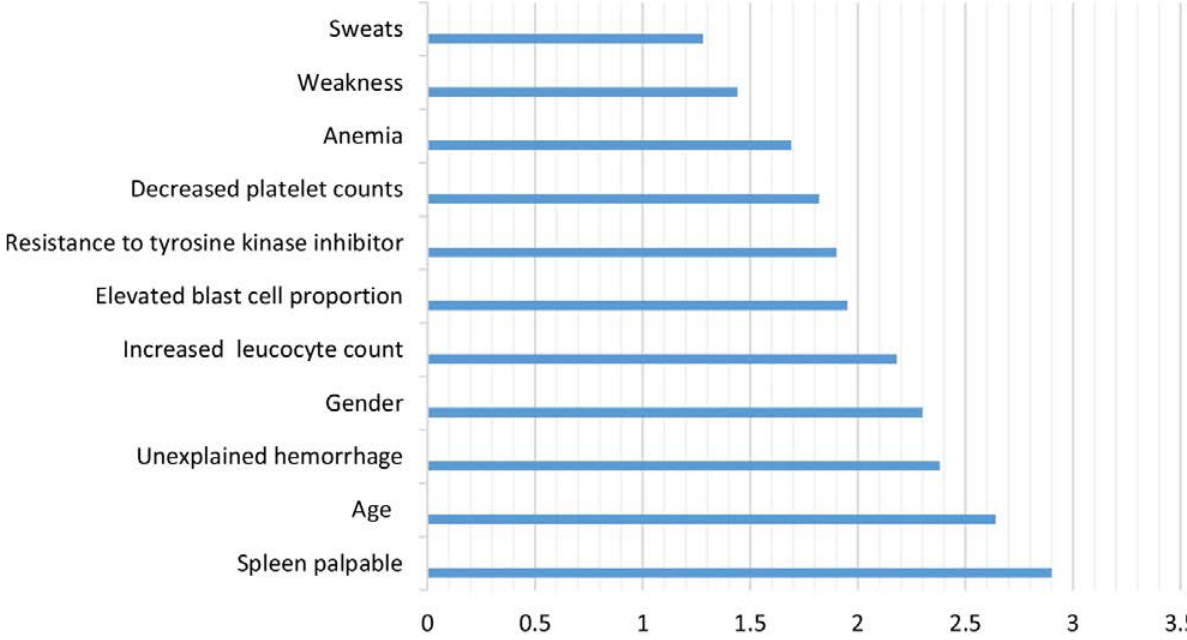
Figure 6. The most important variables selected by the mRMR (Shanbehzadeh et al., 2022) [31]. One of the main goals of imatinib treatment in patients with chronic phase CML (CP-CML) is achieving MMR within two years of the diagnosis because it is associated with improved prognosis and survival [41–44]. Studies have shown that the EUTOS long-term survival (ELTS) score is a good predictor of survival in CML patients [45,46]. A model built by Kok et al. utilized multiple bioassays to classify CML-CP patients into high-risk (HR) and low-risk (LR) groups and to compare it to the ELTS score to determine which is a better predictor of MMR. In addition, they combined the bioassay model